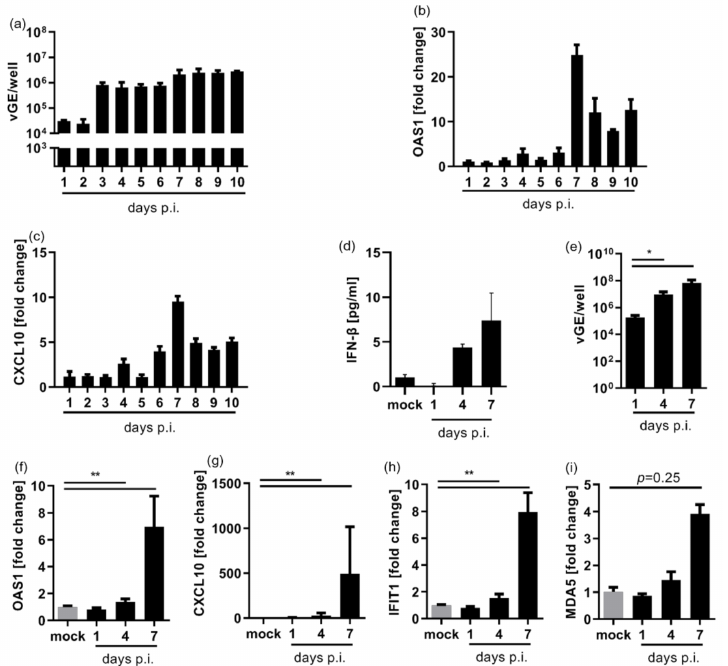
Figure 1. HDV replication induces a Type I interferon response in hepatoma cell lines. NTCP- expressing hepatoma HepaG2 and HepaRG cell lines were infected with HDV and extracted RNA was subjected to qRT-PCR. ( a ) Absolute numbers of vGE/well detected in HepaRG-cells seeded in a 6-well plate. Bars represent a single experiment with biological triplicates. ( b , c ) Upregulation of the ISG OAS1 ( b ) and CXCL10 ( c ) in HDV-infected HepaRG-cells is given as fold induction